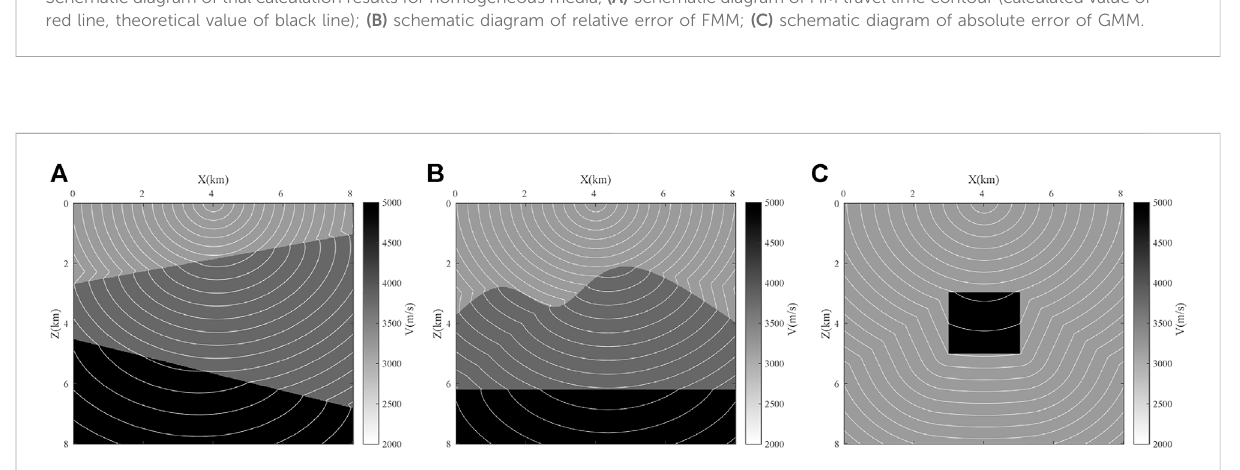
FIGURE 4 Travel time contour maps of the three algorithms, (A) FIM contour; (B) FMM contour; (C) GMM